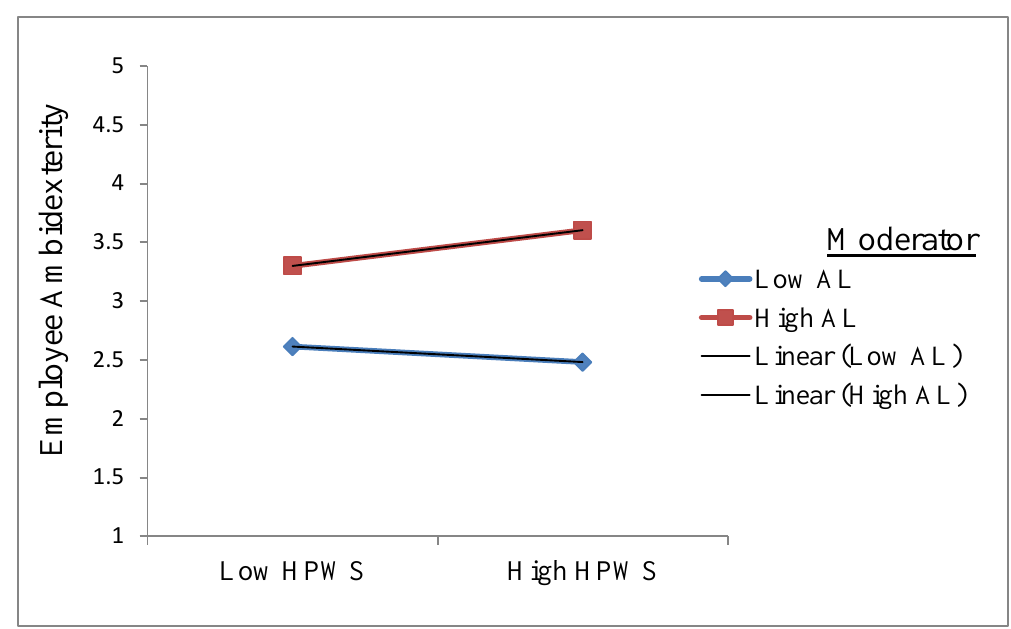
Figure 2. Structural Equation Model